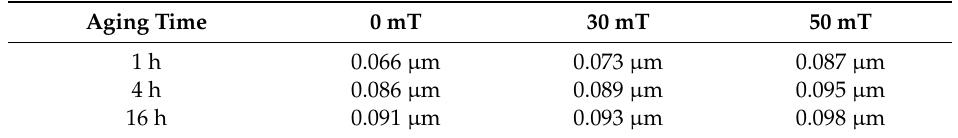
Figure 8. Quantitative measurements of the δ phase in EMS-LSFed Inconel 718 superalloy samples fabricated with di ff erent electromagnetic field intensities. ( a – c ) are average length, average width, and length-width ratio of the δ phase, respectively). Table 6. The influence of the electromagnetic field within the average width of the δ phase for di ff erent aging times.